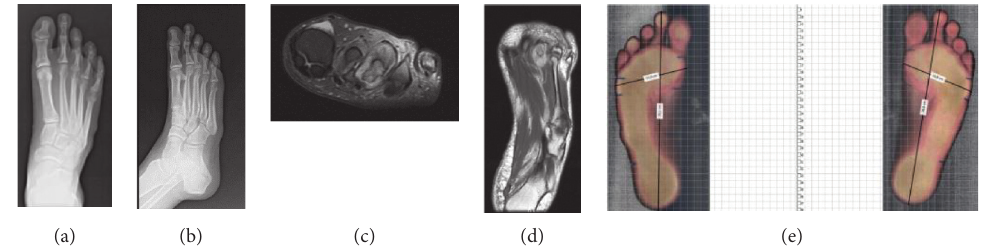
Figure 8: (a–e) Results of imaging tests (X-ray, MRI) and foot scanning: patient no. 10. (a) Dorsal-plantar X-ray: degradation lesion of the III head of the metatarsal bone and numerous transverse calcifications. (b) Diagonal X-ray of foot 45: degradation lesion of the III head of metatarsal bone and numerous calcifications. (c) Magnetic resonance imaging with contrast: degradation lesion of the III head of the metatarsal bones and medial plantar nerve neuralgia. (d) Magnetic resonance imaging with contrast: degradation lesion of the III head of the metatarsal bone and medial plantar nerve neuralgia. (e) Plantar photo from 2D Scanner: assessment of plantar part of the foot and measurement of foot length and